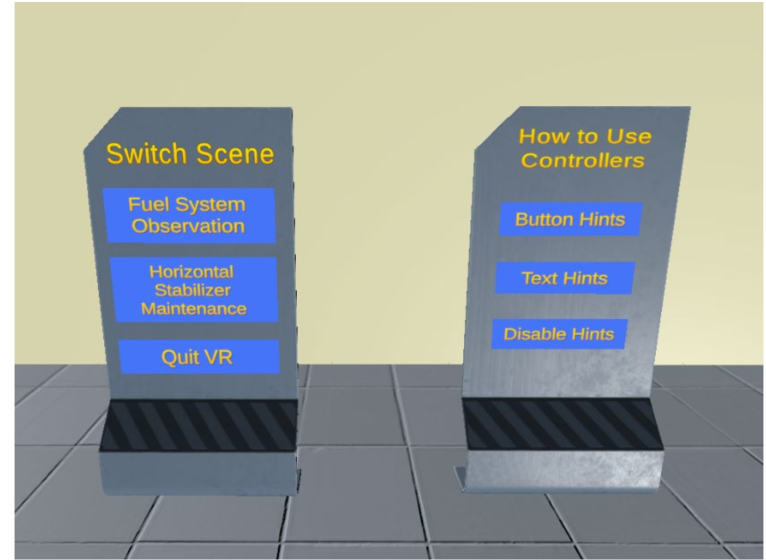
Figure 7. Two different UI object in the VR training system.